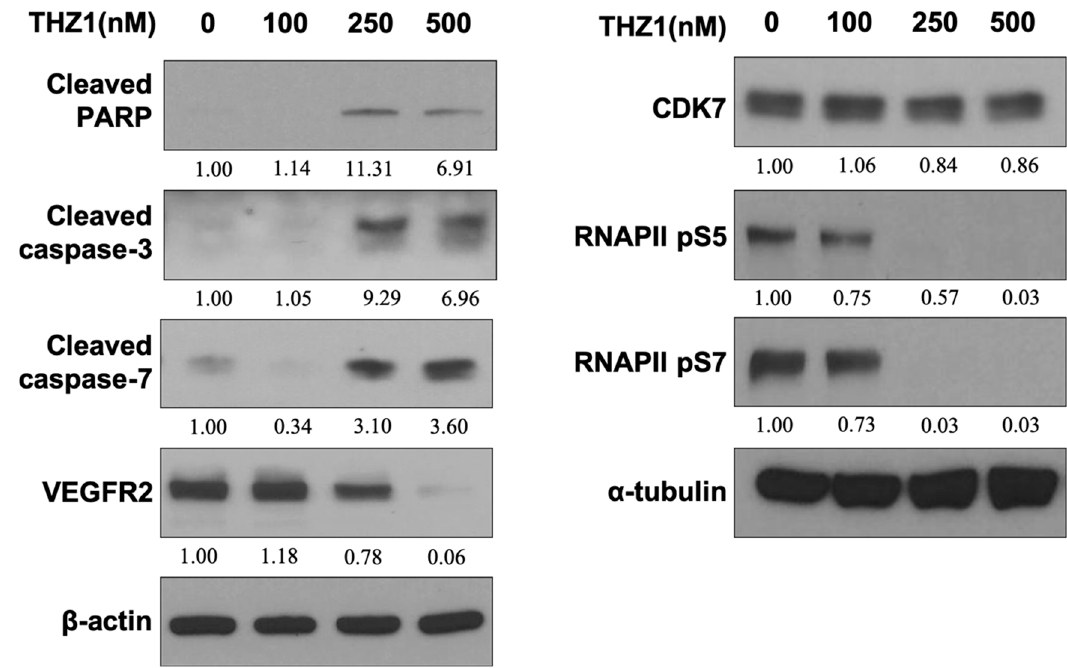
Figure 3. THZ1 induced apoptosis and suppressed VEGFR2 expression and RNA polymerase II (RNAPII) C-terminal domain (CTD) phosphorylation at serine 5 and 7 in HUVECs . HUVECs were treated with various concentrations of THZ1 (100–500 nM) for 48 h. Cell lysates were harvested and subjected to Western blotting using specific antibodies against cleaved caspase-3, cleaved caspase-7, cleaved PARP, VEGFR2, CDK7, RNAPII p55, and RNAPII pS7. Numbers under the plots indicate the fold change of protein level relative to their untreated control. The illustrated results are representative of at least three independent experiments.